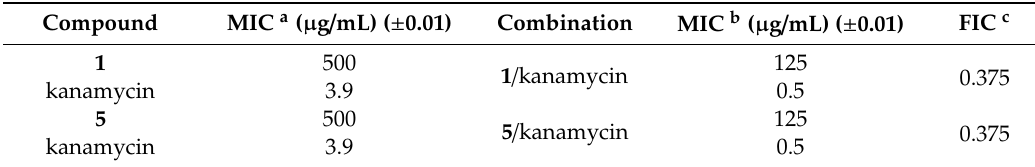
Table 7. Synergistic e ff ects against S. aureus demonstrated by 1 and 5 upon their combination with